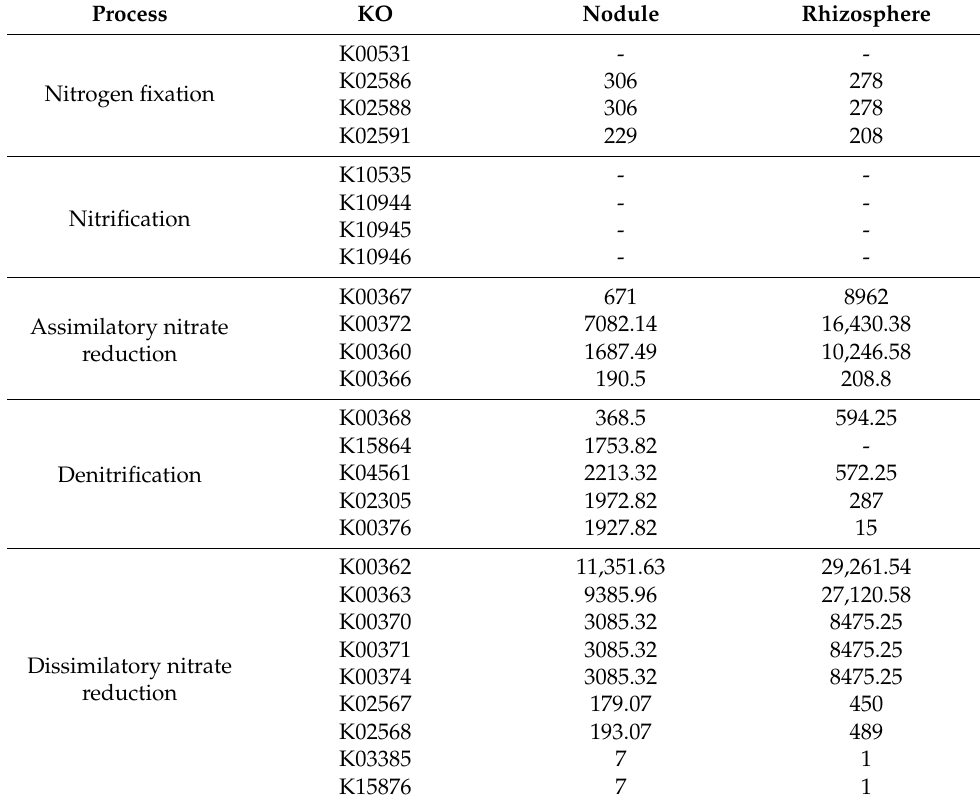
Figure 5. Correlation plot on functional orthologs predicted by PICRUSt 2 software (nodule y axis and rhizosphere x axis). In Figure the KO codes refer to the KEGG Orthologs of KEGG database. Only KOs with relative counts higher than 100,000 were labeled in black. The label in magenta shows the KO with higher counts in rhizosphere. Correlation coefficient: 0.73. Table 3. Relative counts of the selected KEGG orthologs associated with nitrogen cycle predicted through PICRUSt